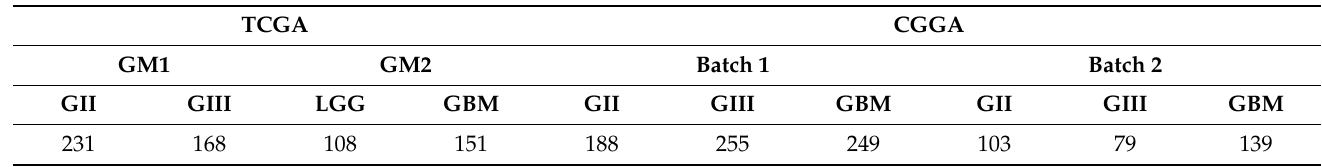
Table 1. A summary of sample amounts used in the analysis to obtain and validate results. In total, 1671 publicly available samples were used in this